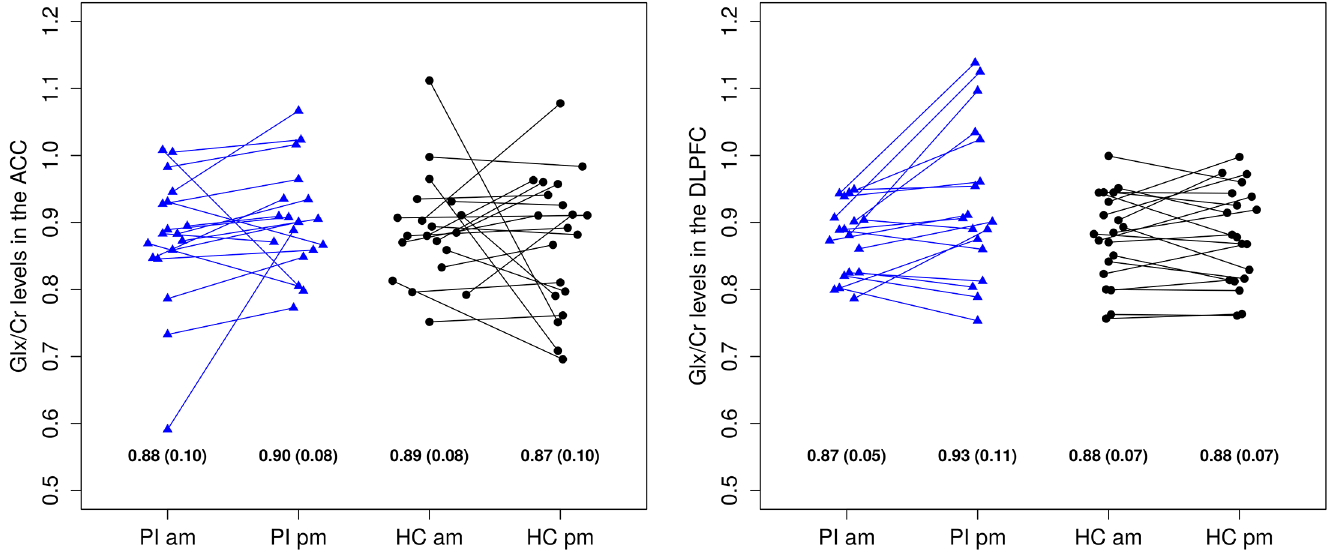
Fig 4. Glx/Cr concentration ratios in the ACC (left) and DLPFC (right) sorted by group and measurement time. There was a significant interaction effect GROUP x MEASUREMENT TIME on Glx/Cr levels in the DLPFC (t[36] = 2.35; p = 0.024). For each group and measurement time, means (standard deviations) are presented at the bottom of the figure. Glx: glutamate and glutamine; Cr: creatine; DLPFC: dorsolateral prefrontal cortex; PI: primary insomnia; am: ante meridiem; HC: healthy controls; pm: post meridiem.